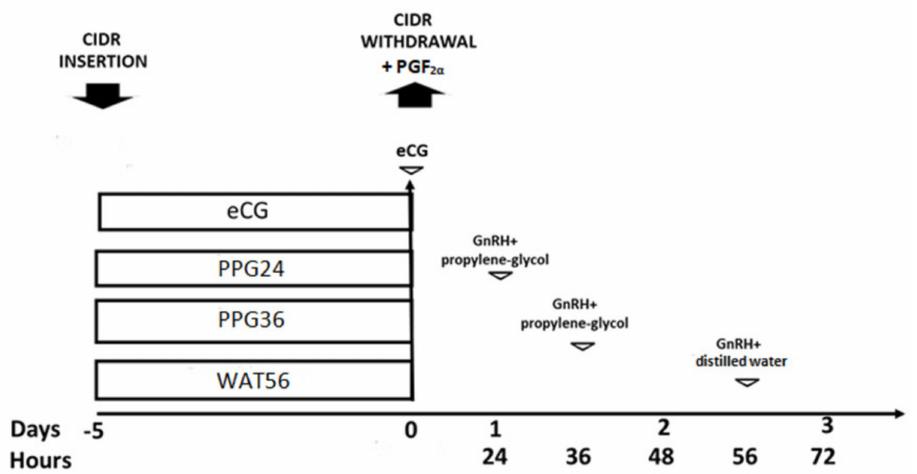
Figure 2. Experimental groups of trial 2, aiming to determine the e ff ect and adequate timing of GnRH administration in either distilled water or propylene glycol on the ovarian response to progesterone-based protocols. All females were treated with one controlled internal drug release (CIDR) device with PGF 2 α and 400 IU of equine chorionic gonadotrophin (eCG; group eCG, n = 8) or a single dose of 50 µ g of GnRH in either i.m. distilled water (56 h after CIDR removal; group WAT56, n = 8) or s.c. propylene-glycol (24 or 36 h after CIDR removal; groups PPG24, n = 11; and PPG36, n =